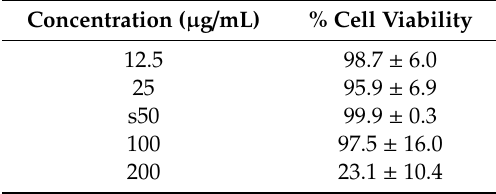
Table 3. Cytotoxicity of Z. kerrii rhizome extract on HaCaT cells after 24 h